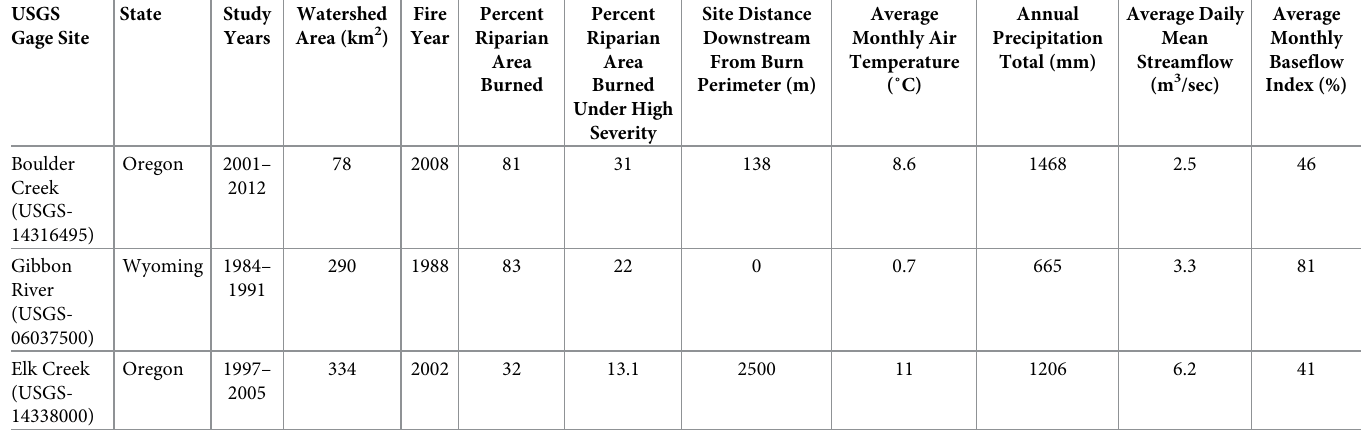
Table 1. Physiographic, climatic, hydrologic, and burn characteristics of studied gages. The climatology was based on the 1980–2010 period. The daily mean discharge and monthly mean baseflow index represent the pre-fire streamflow condition. USGS Gage